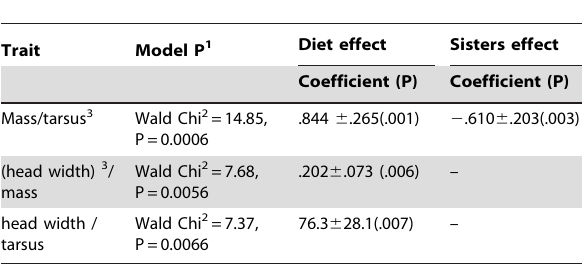
Table 2. Effects of diet and natal brood composition (‘‘sisters’’) on residuals of male body